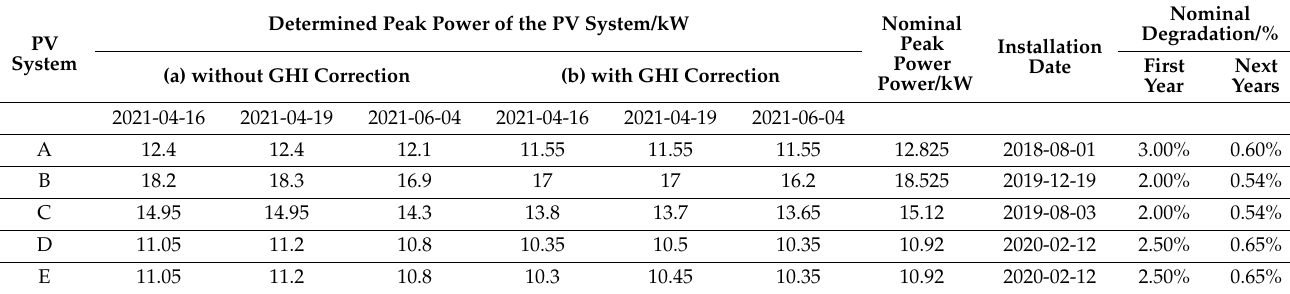
Table 1. Peak power values determined with PVcheck for five different PV systems and three sunny days each. The calculations include a correction by the incident angle modifier for direct and diffuse light. The numbers are furthermore corrected for inverter efficiency and module lowlight behaviour to show the peak power of the modules. Electrical cable losses are neglected. Part (a) shows results obtained with the Ineichen clearsky model only (without GHI correction). Part (b) includes a correction factor (measured GHI/simulated clearsky GHI) for the simulated irradiation. The nominal peak power is the given module power at standard test conditions from the datasheets, multiplied by the number of modules. For each system, the maximum allowed degradation from the datasheets is given on the right.